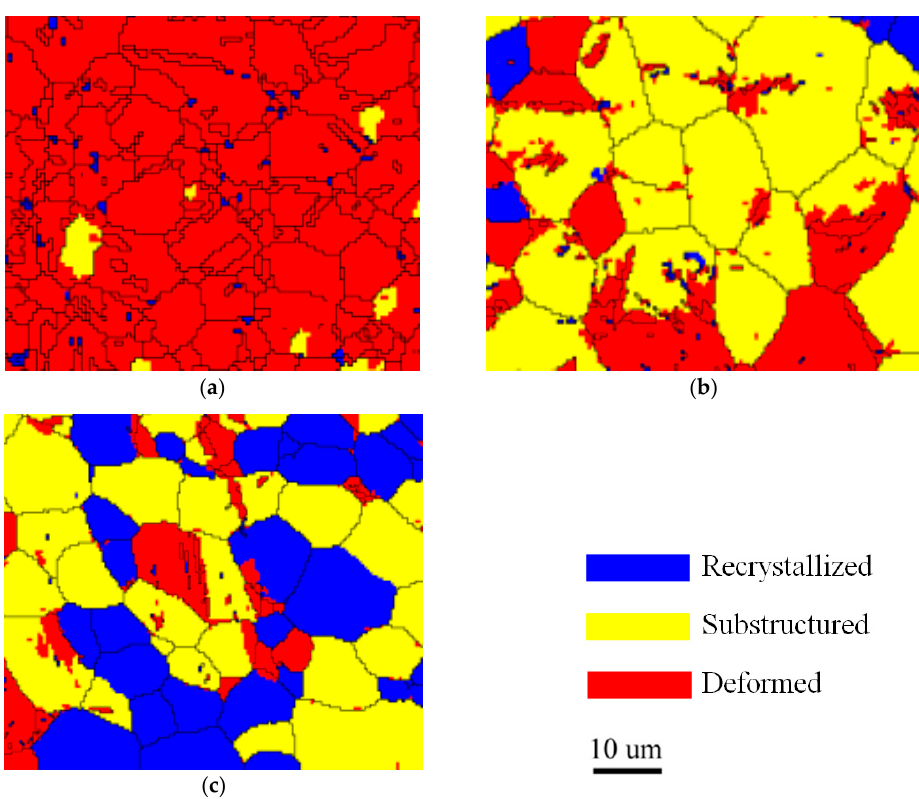
Figure 8. Distribution maps of the recrystallized, substructured and deformed grains: ( a ) 20 °C, ( b ) 150 °C, ( c ) 250 °C.